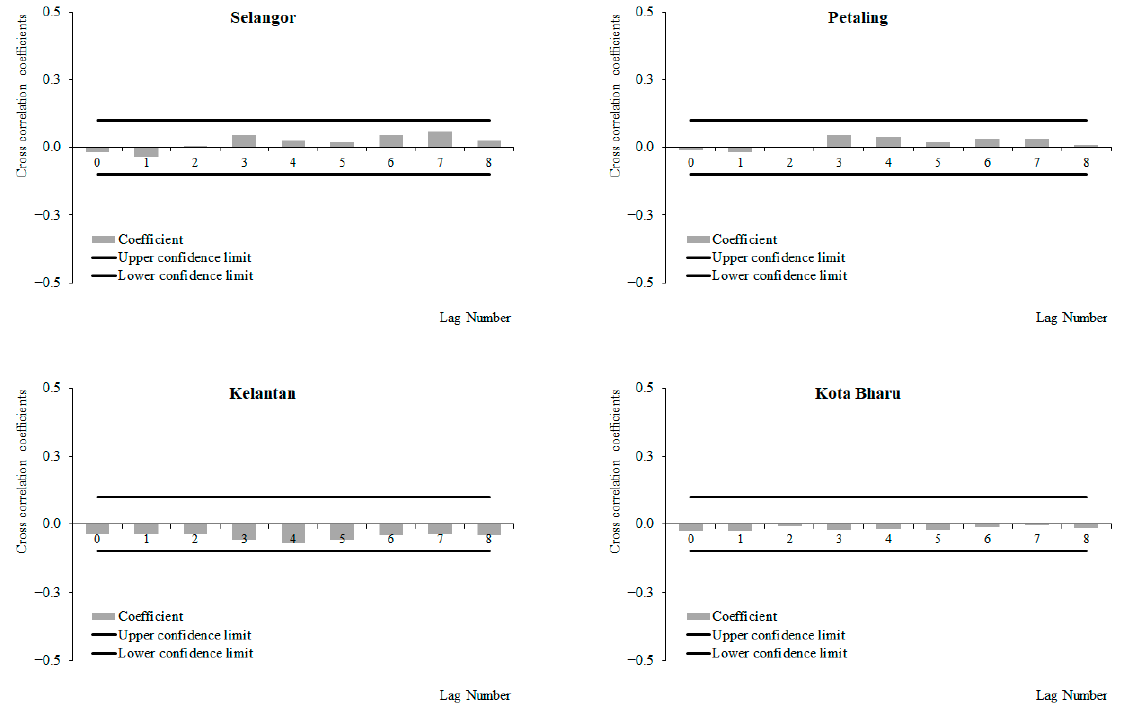
Figure 8. Cross-correlation function between dengue cases and rainfall in Selangor, Petaling, Kelantan and Kota Baharu, 2011 to 2014.